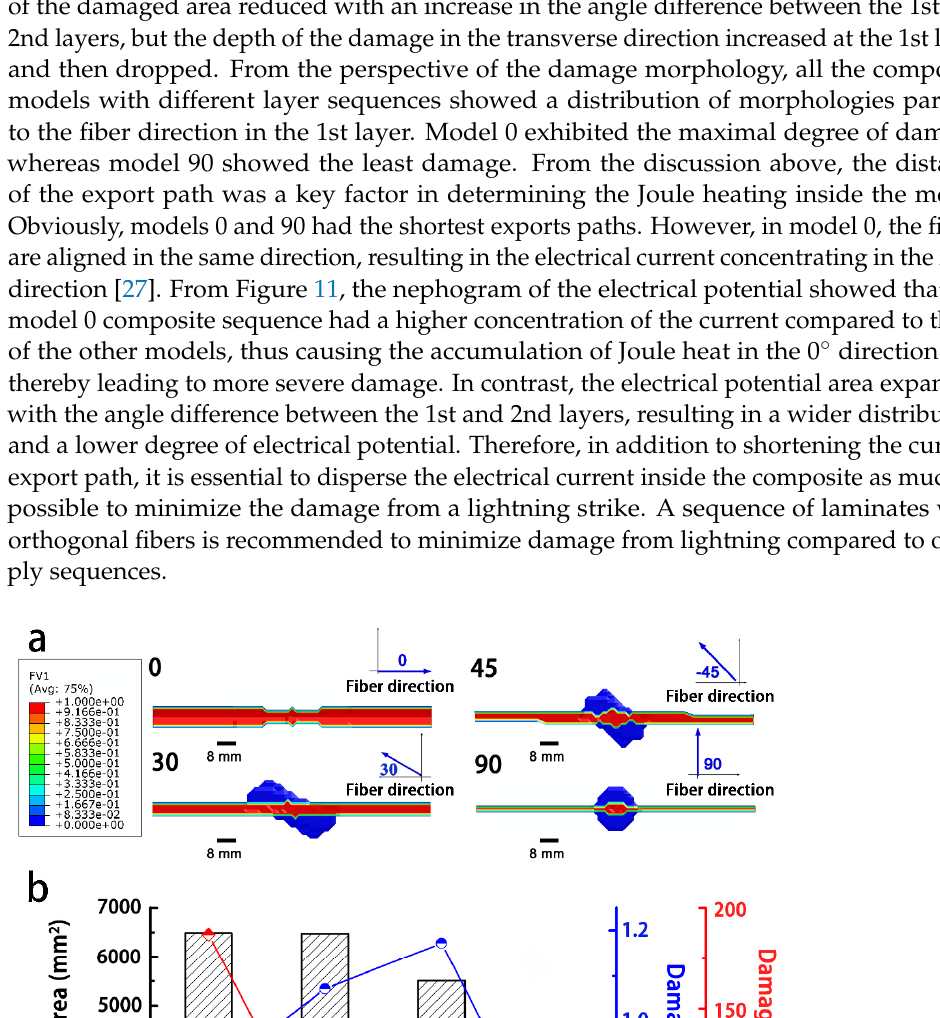
Figure 11. Potential distributions at the surface of the composites with different layup sequences. 3.2. Influence of the Composite Properties on the Extent of Lightning Damage Although many factors can influence the extent of the lightning damage to a compo- site, the thermal and electrical properties of materials undoubtedly play a dominant role. In this section, anisotropies in the thermal and electrical properties of the composites are discussed. 3.2.1. Electrical Conductivity As shown in Figure 12, increasing the electrical conductivity along the fiber direction ( σ 11 ) effectively enhanced the current dissipation in the composite and reduced the extent of the in-plane damage, but the damage along the depth of the composite was unchanged.